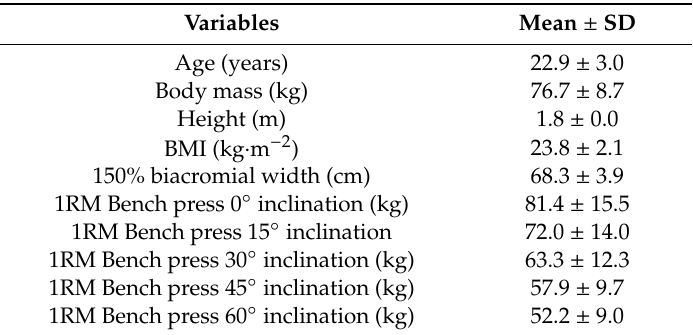
Table 1. Descriptive characteristics of the sample group. Mean ± standard deviation. BMI: body mass index, 1RM: one-repetition